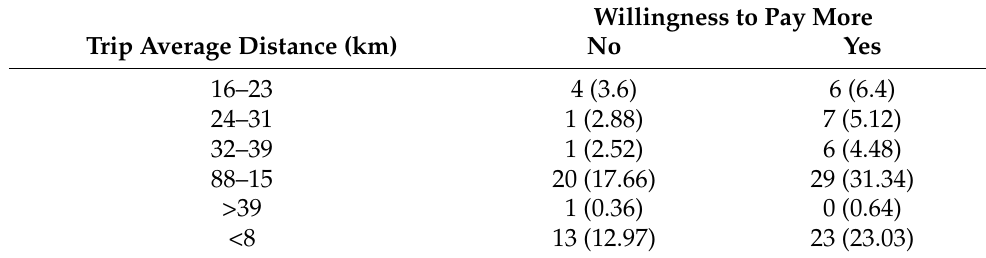
Table 6. Observed and expected willingness to pay more based on trip